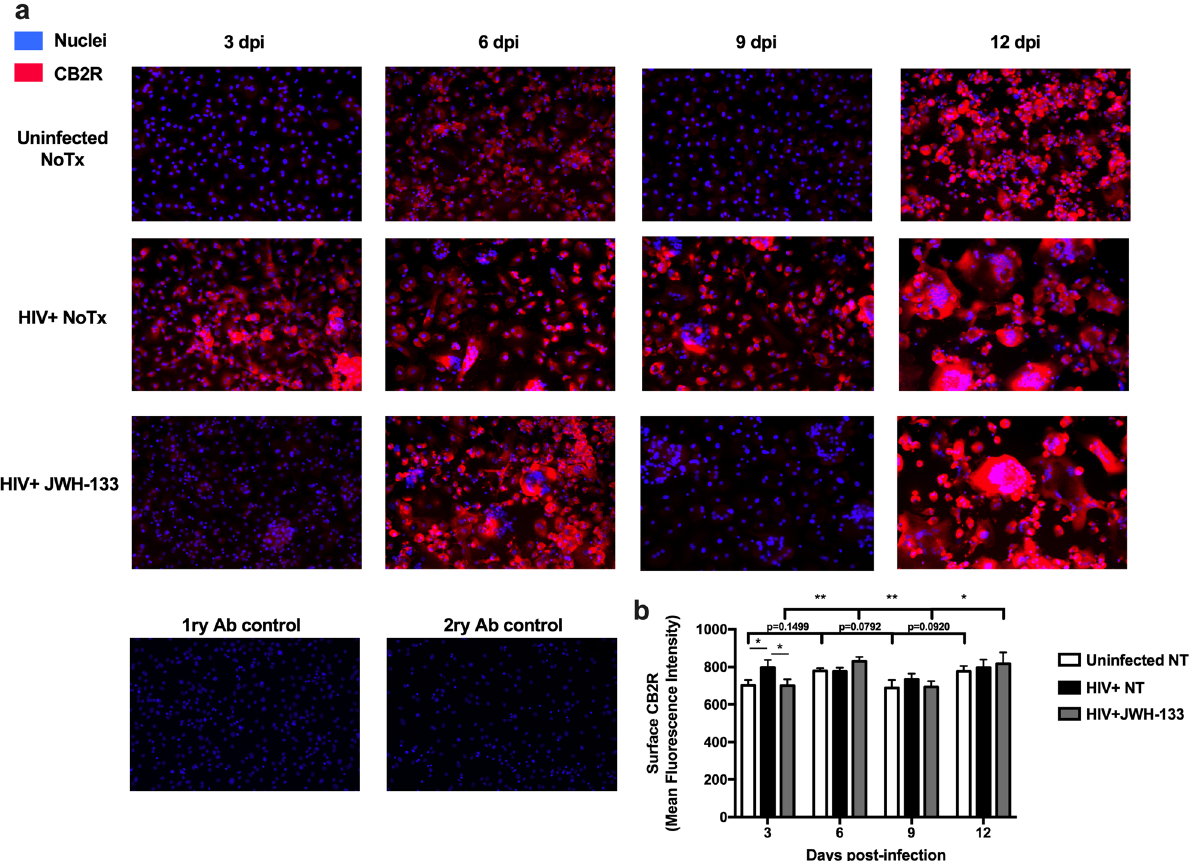
Figure 3. JWH-133 prevents HIV-induced increase in surface CB2R expression and induces oscillating expressions over time. MDM were cultured in 8-well chamber slides, infected with HIV-1 ADA , and treated with JWH-133 at 0.5 µM. Slides were fixed at days 3, 6, 9, and 12dpi. Cells were stained with an anti-CB2R antibody (red) and nuclei were stained with DAPI (blue). At least 3 different random pictures per condition were acquired. Representative immunofluorescence images are shown. Graphs are presented using the mean ± standard error of the mean (SEM). This figure is representative of three different donors (n = 3). * p < 0.05, ** p <